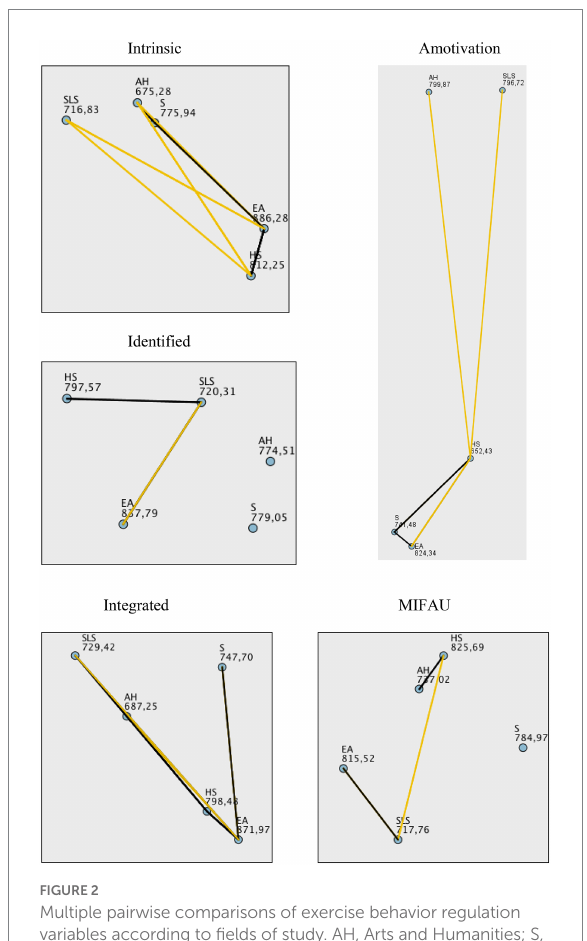
FIGURE 2 Multiple pairwise comparisons of exercise behavior regulation variables according to fields of study. AH, Arts and Humanities; S, Sciences; HS, Health Sciences; EA, Engineering and Architecture; SLS, Social and Legal